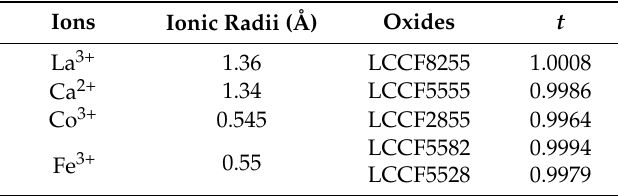
Table 1. Radii of the doping ions and t values of prepared samples.